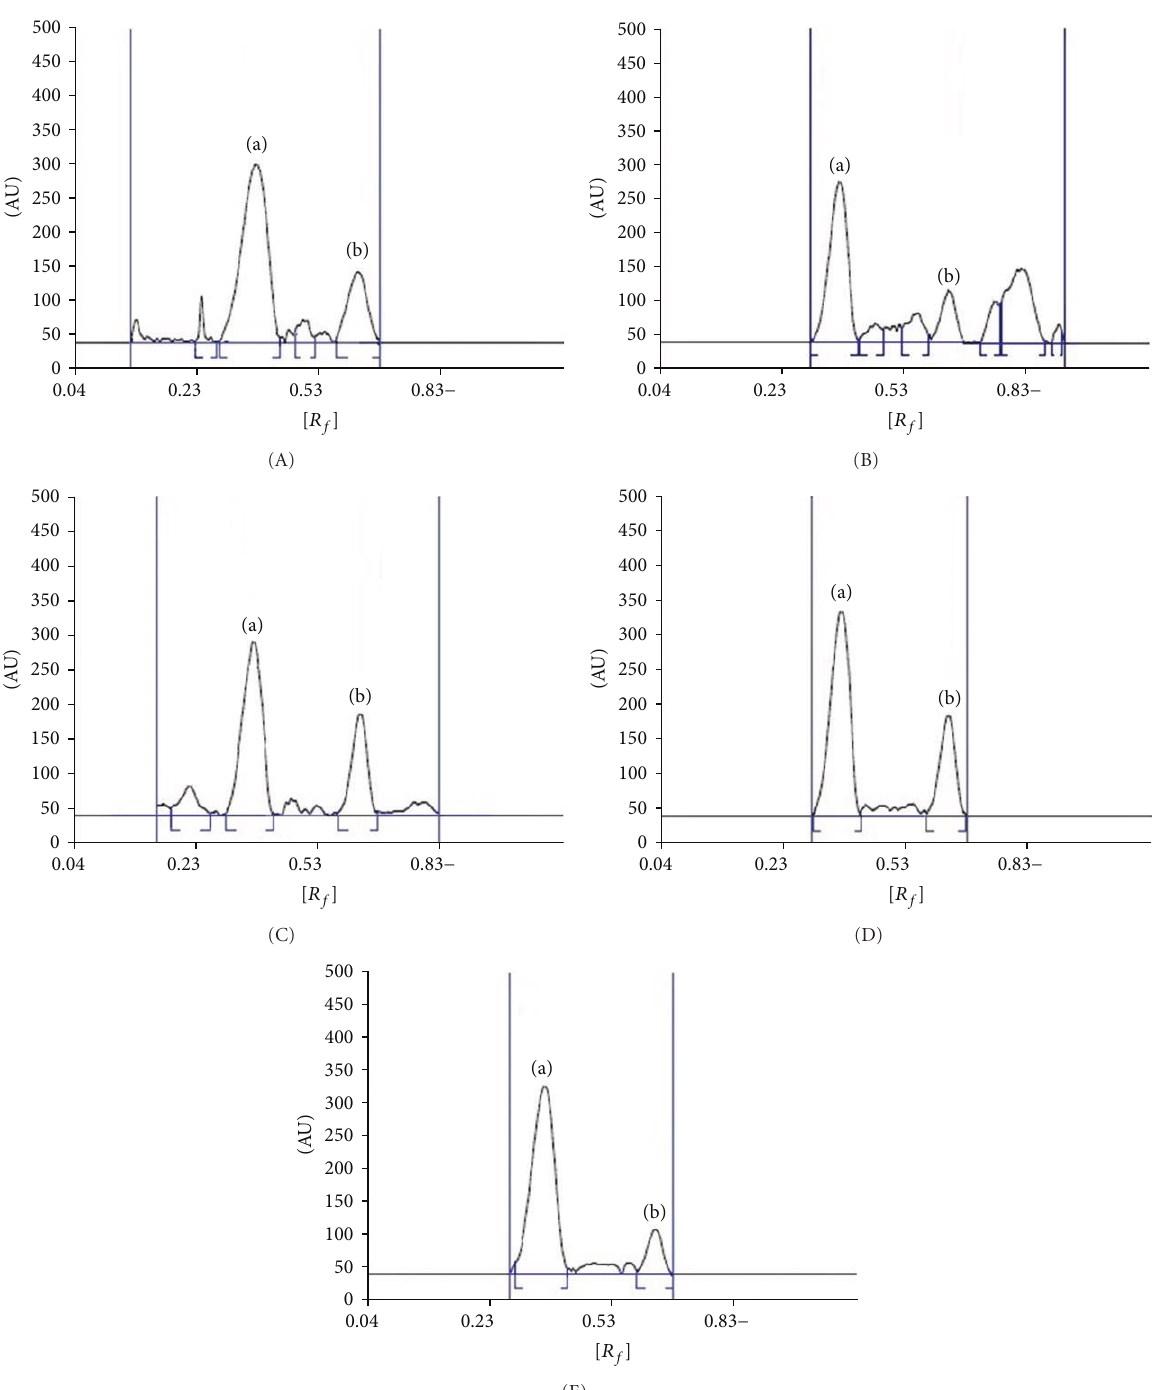
Figure 7: Chromatograms of (a) TLM and (b) ATV obtained from degradation studies: acid hydrolysis (0.1M HCl, 60 ∘ C, 1hr) (A); alkaline hydrolysis (0.1M NaOH, 60 ∘ C, 1hr) (B); oxidative degradation (3% H 2 O 2 , 60 ∘ C, 1hr) (C); thermal degradation (dry heat, 60 ∘ C, 1hr) (D); and photolytic degradation (UV-chamber, 254 nm, 24hrs)